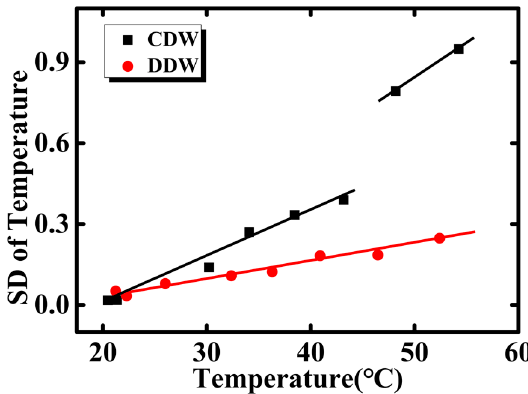
Figure 8. The standard deviation of temperature fluctuation change with temperature when using CDW or DDW as coolant.